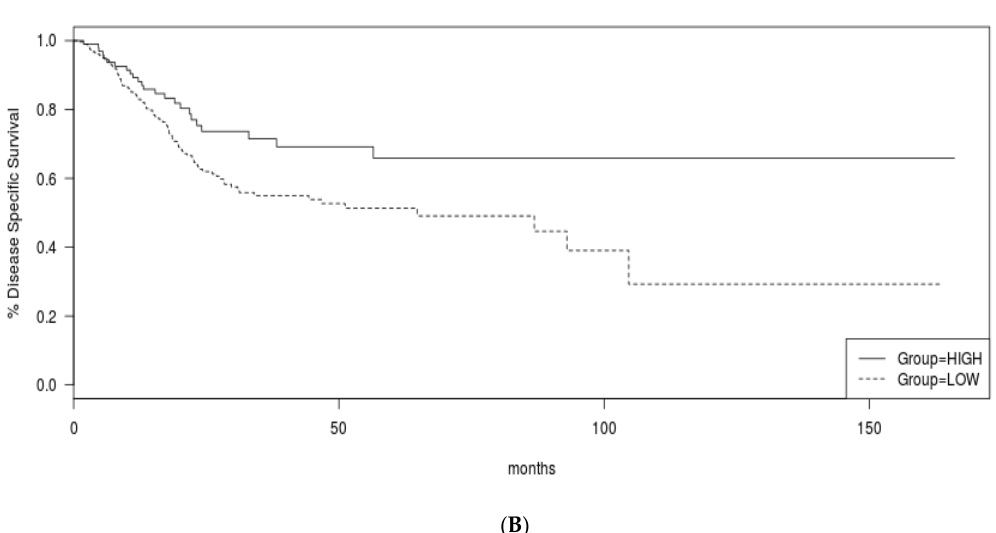
Curr. Oncol. 2022 , 29,